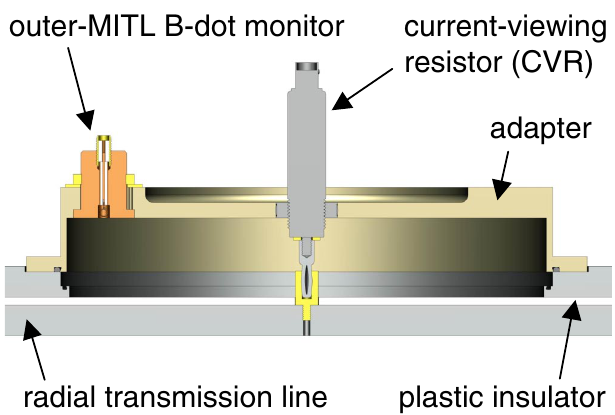
FIG. 4. (Color) Cross-sectional view of the central region of the B -dot calibration